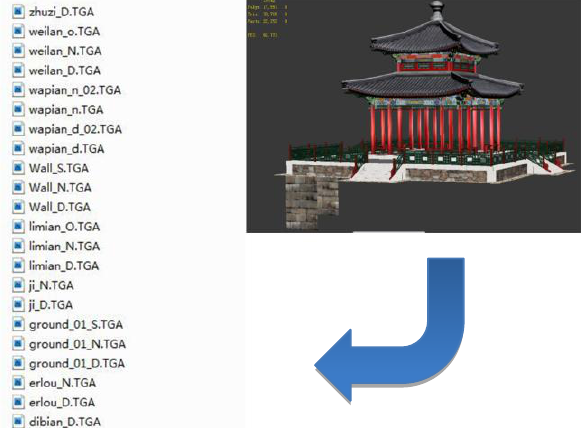
Figure 6. Map of the Present Liuxiangzhu Pavilion 3D